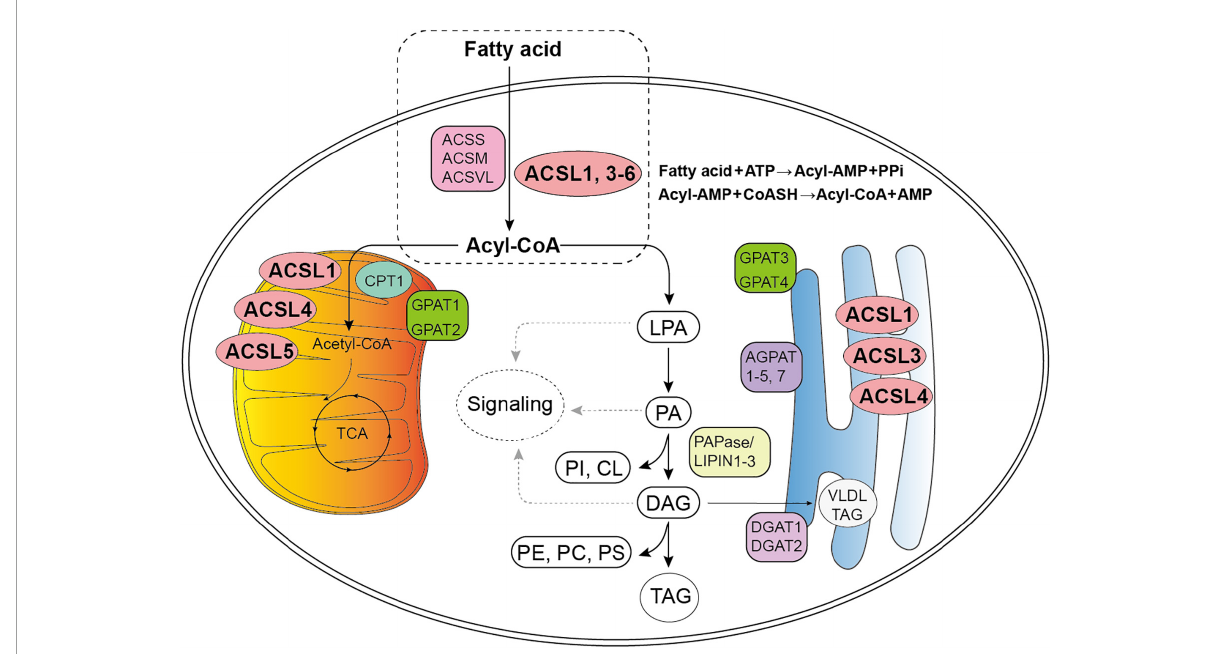
FIGURE1 Diagram for fatty acid (FA) metabolism. The first stage of FA metabolism is the activation of FA, which requires a two-step reaction catalyzed by Acyl-CoA synthetases: an acyl-AMP intermediate is first formed from ATP, and then exchanged with CoA to yield the activated acyl-CoA. (Gassler et al., 2007; Soupene and Kuypers, 2008; Golej et al., 2011; Nakahara et al., 2012; Rossi Sebastiano and Konstantinidou, 2019). Subsequently, Acyl-CoA participates in the synthesis of lysophosphatidic acid (LPA), phosphatidic acid (PA), glycerol diester (DAG), and triacylglycerol (TAG) (Coleman, 2019). Acyl-CoAs can also be converted to acyl-carnitines by carnitine palmitoyltransferase (CPT1) to enter the mitochondria for β -oxidation and tricarboxylic acid cycle (TCA). The LPA, PA, and DAG intermediates may initiate signaling cascades, and PA and DAG are also precursors of all the glycerophospholipids: phosphatidylinositol (PI), phosphatidylcholine (PC), phosphatidylethanolamine (PE), phosphatidylserine (PS), and cardiolipin (CL) (Coleman, 2019). The TAG may remain in the cytosol within a lipid droplet or, in liver, be secreted a part of a very-low-density lipoprotein particle (VLDL) (Coleman, 2019). ACSS, short–chain acyl–CoA synthetase; ACSM, medium–chain acyl–CoA synthetase; ACSL, long–chain acyl–CoA synthetase; ACSVL, very long–chain acyl–CoA synthetase; AMP, adenosine monophosphate; PPi, pyrophosphoric acid; CoASH, coenzyme A; GPAT, glycerol-3-P acyltransferases; AGPAT, 1-acylglycerol-3-phosphate acyltransferases (also known as LPA acyltransferase); PAPase/Lipin, PA hosphohydrolases; DGAT, diacylglycerol